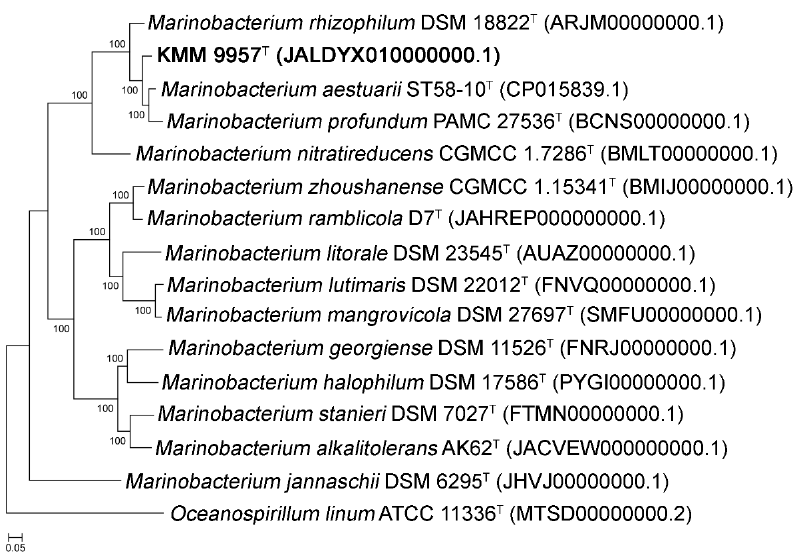
Figure 2. Maximum-likelihood tree based on concatenated 400 protein sequences from genome sequences showing phylogenetic position of the novel strain KMM 9957 T among Marinobacterium species and related taxa. Bootstrap values are based on 100 replicates. Oceanospirillum linum ATCC 11336 T was used as an outgroup. Bar, 0.05 substitutions per amino acid